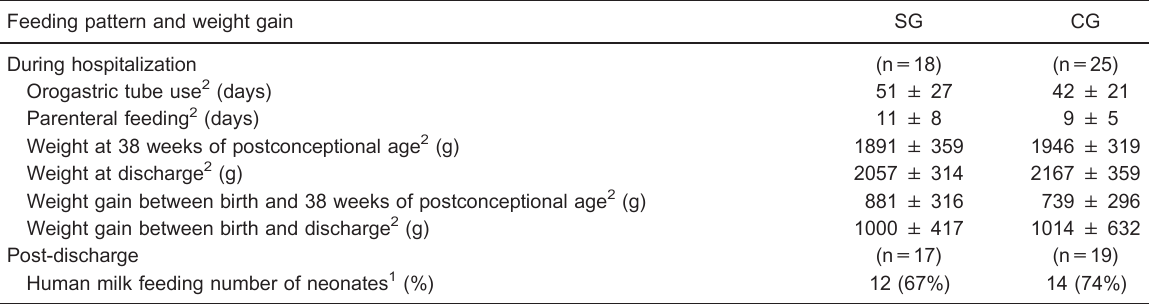
Table 2. Feeding pattern and weight gain outcomes of preterm infants. Feeding pattern and weight